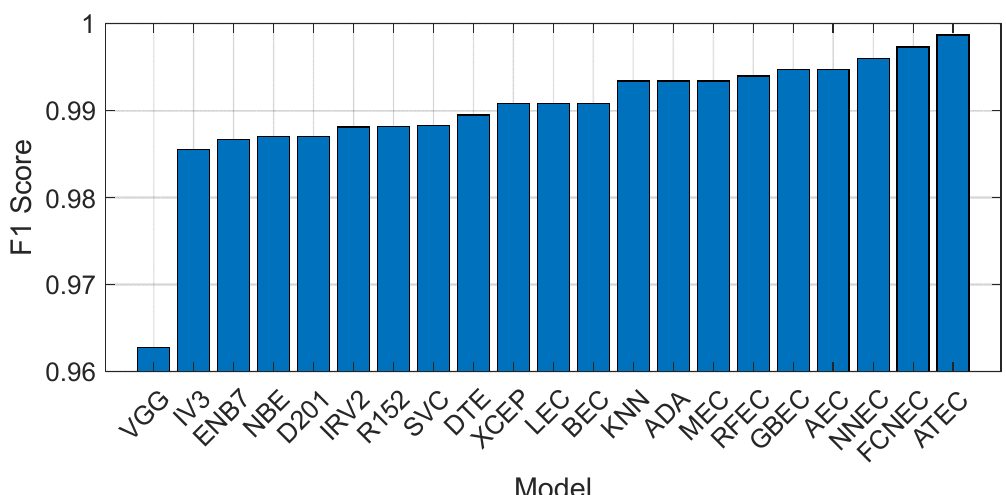
Figure 17. Prediction Accuracy.